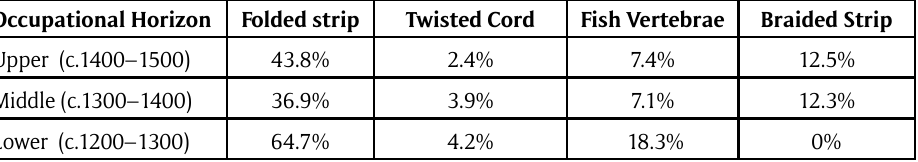
Table 2: Roulette types as an overall percentage of decorative motifs in the three occupational horizons of Unit A.